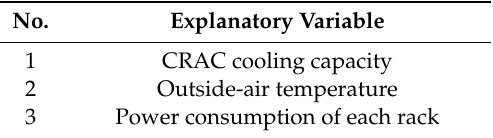
Table 5. Explanatory variables used by the baseline